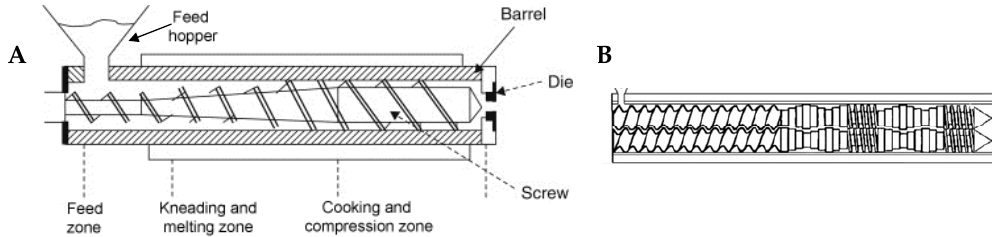
Figure 2. Schematic representation of a cooking extruder with a single screw ( A ) and detail of twin screws ( B ).